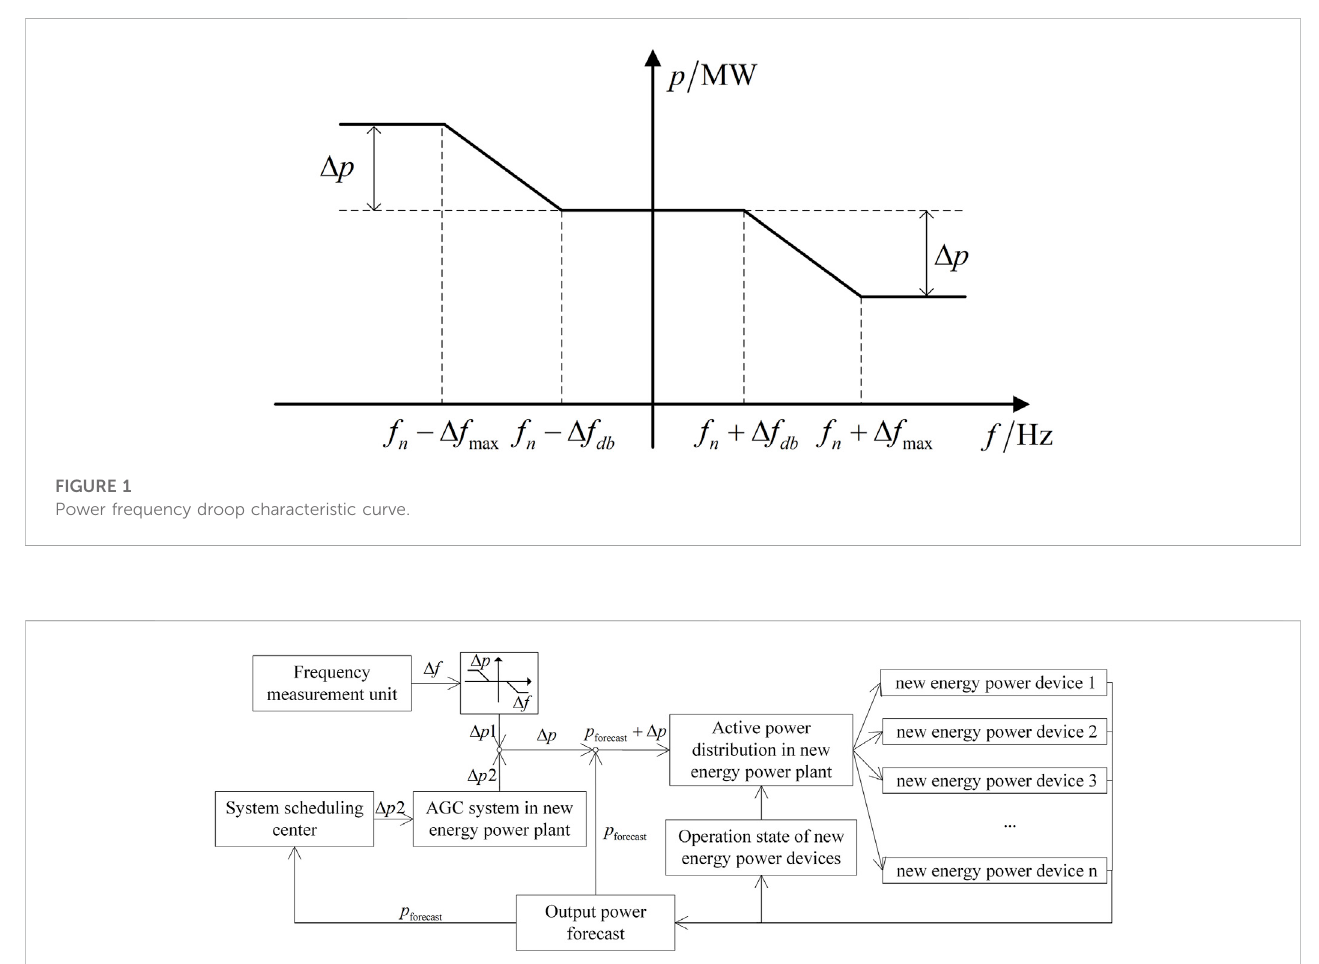
FIGURE 2 Frequency regulation control structure diagram for